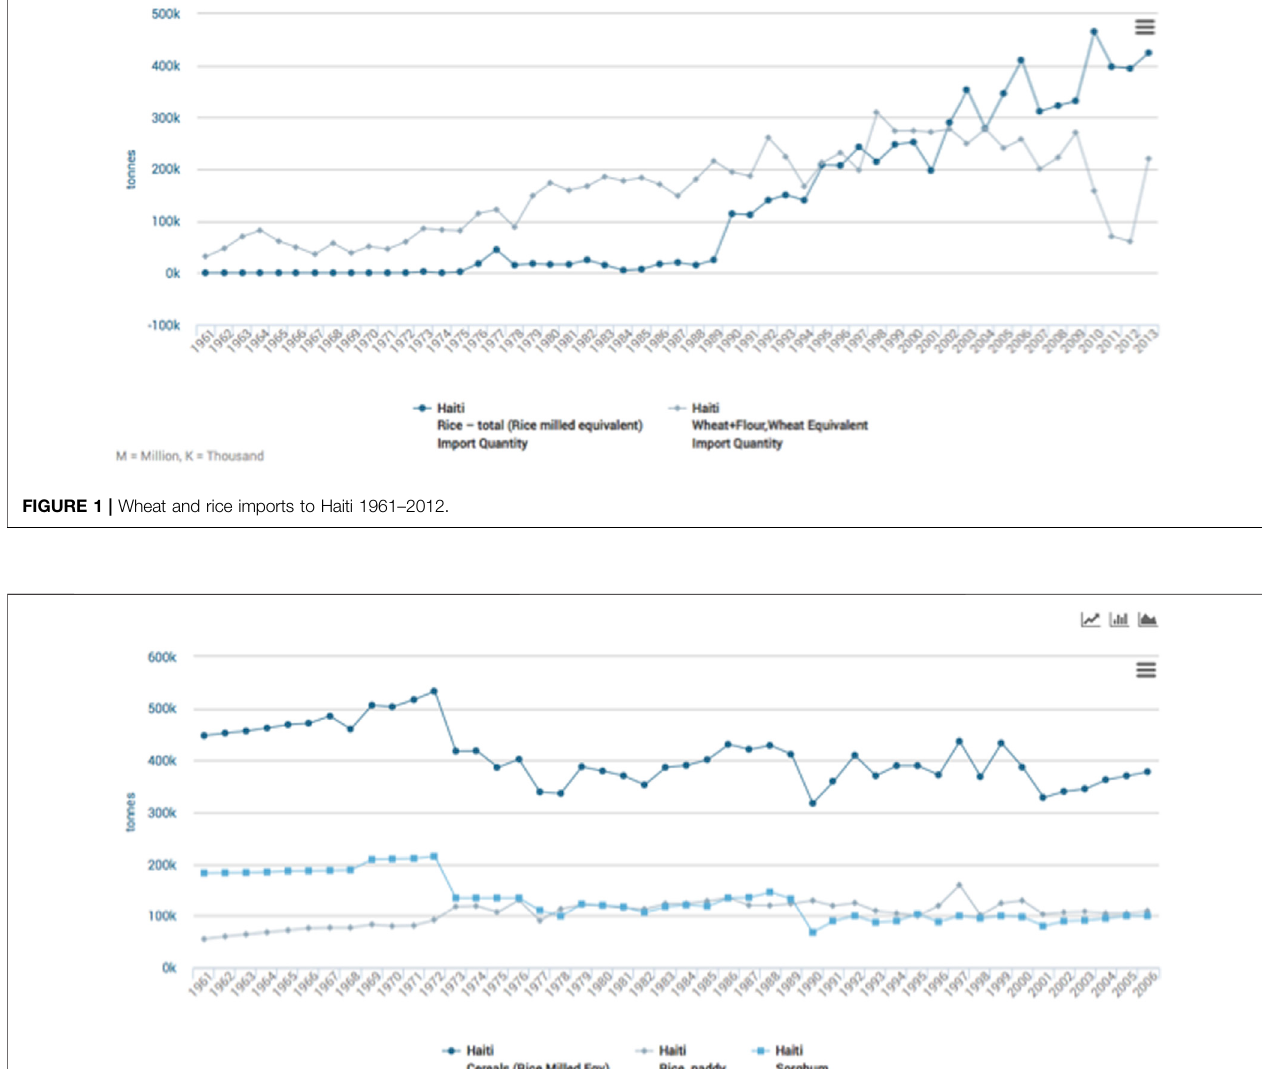
Frontiers in Communication |